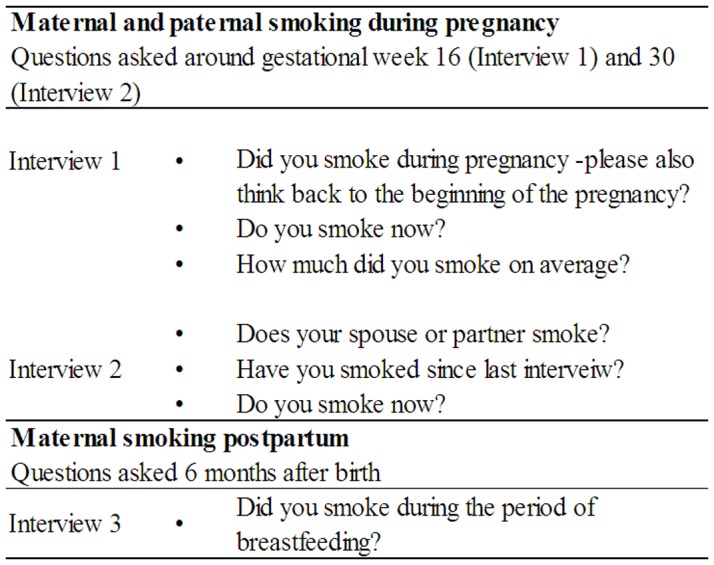
The figure show questions assessing information on maternal and paternal smoking exposure from Interview 1 (obtained around gestational week 16), Interview 2 (obtained around gestational week 32), and Interview 3 (obtained 6 months after child birth).